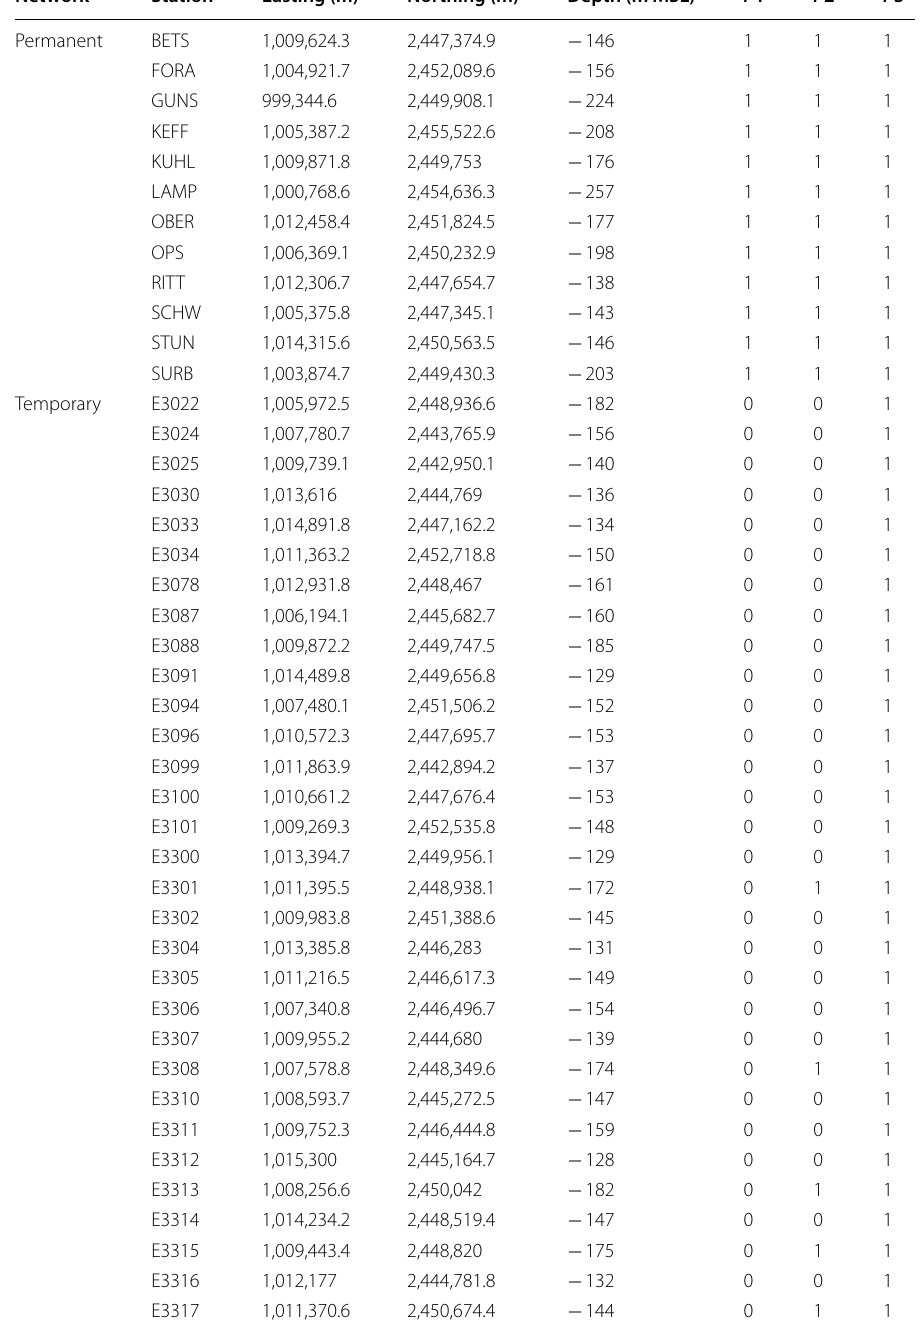
Table 4 Seismic station locations (in the extended Lambert II Cartesian coordinate system) and associated recording periods: P 1: from beginning of monitoring; P 2: from GRT-1 chemical and hydraulic stimulation; and P 3: before GRT-2